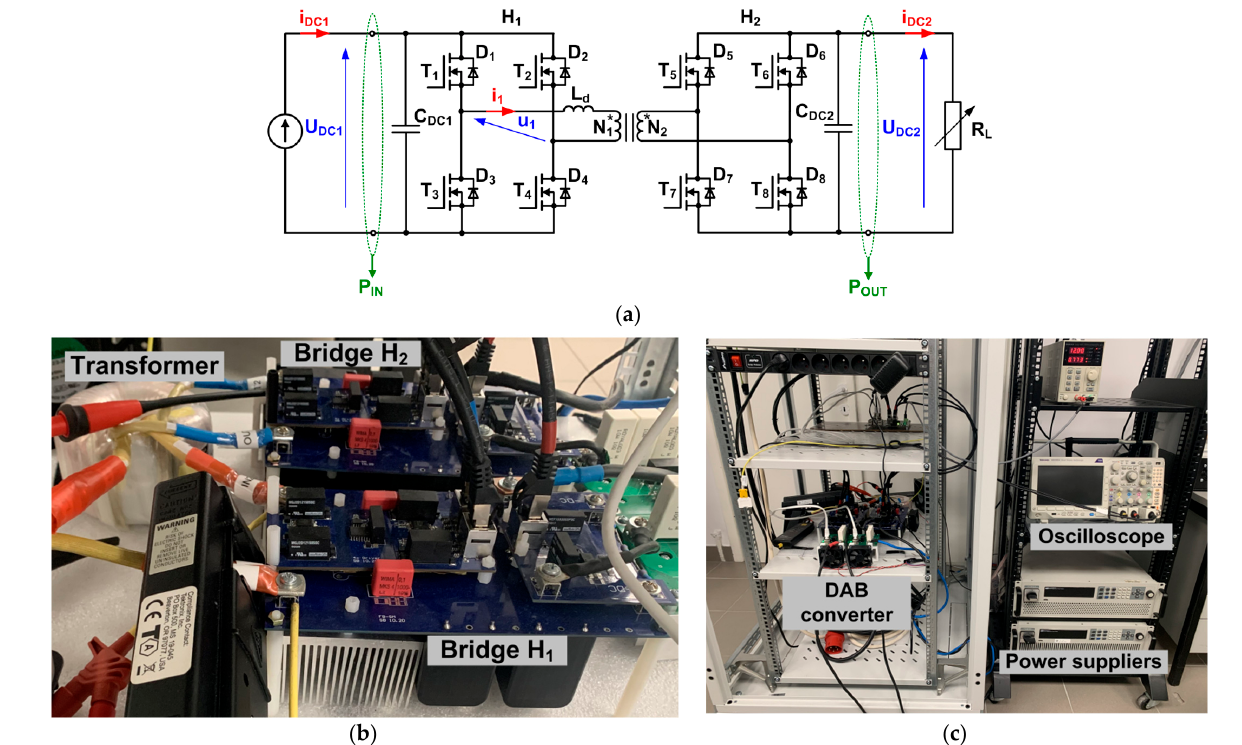
( c ) Figure 11. Simplified waveforms of voltages u 1 , u 2 / n and magnetic induction B for ( a ) U DC 1 = U DC 2 / n ; ( b ) U DC 1 > U DC 2 / n; ( c ) U DC 1 < U DC 2 / n. 6. Validation The parameters that are required for DAB converter efficiency calculation using the proposed approach were collated and are explained in Table 1. The described approach was validated by a comparison of the estimated DAB efficiency characteristics with the experimental ones measured for the converter, whose parameters are shown in Table 2. To measure the input P IN and output P OUT power (Figure 12) of the tested DAB converter, a Yokogawa WT5000 precision power analyzer was used. Importantly, the experimental measurements were performed for the DAB converter in a basic configuration without